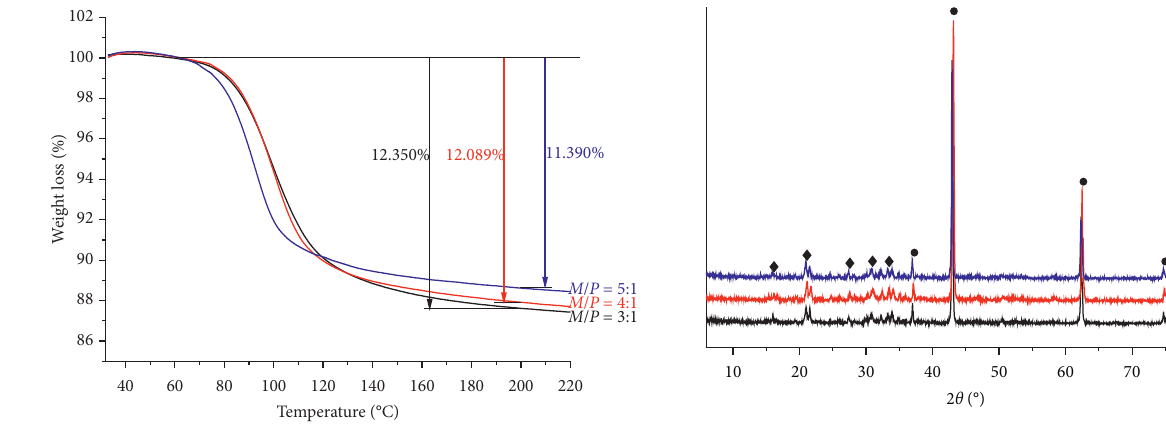
Figure 8: TG curves of MPC with different M / P mass ratios after curing for 28d under air-curing conditions.